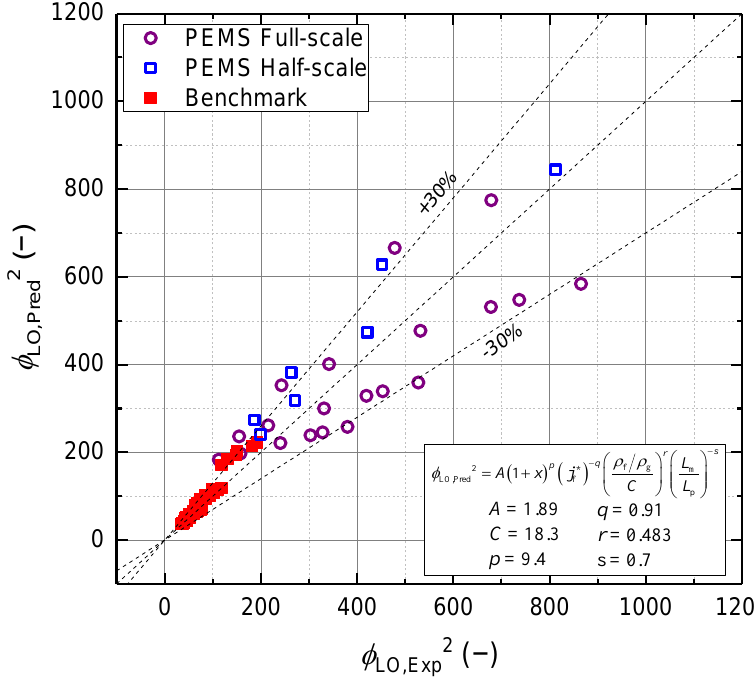
Figure 7. Comparison of empirical correlation with experimental data.